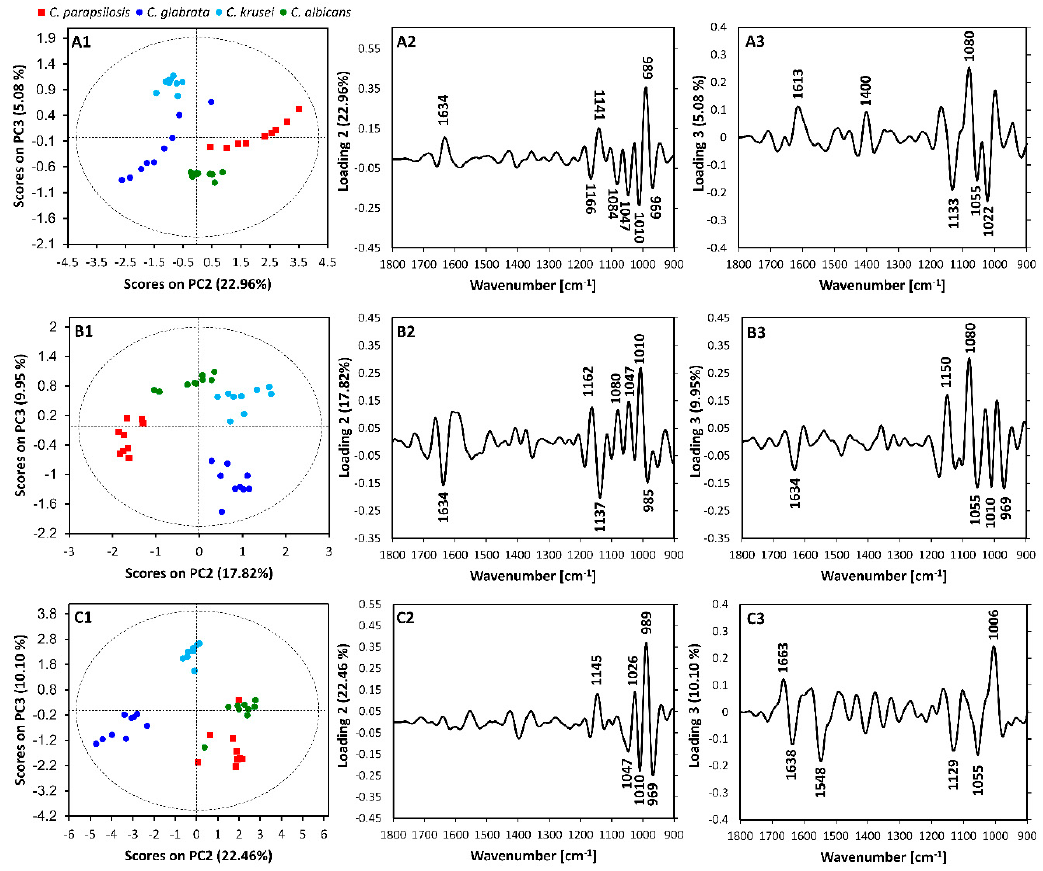
Figure 3. Principal Components (PC) PC2 versus PC3 scores plot for each preparation type: ( A1 ) untreated ( B1 ) fixed and ( C1 ) washed and their corresponding loadings for PC2 ( A2 , B2 , C2 ) and PC3 ( A3 , B3 , C3 ). Table 2. Summary of species discriminatory bands as seen in each preparation type from loadings.